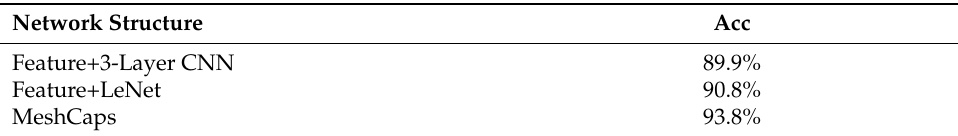
Table 4. Network structure